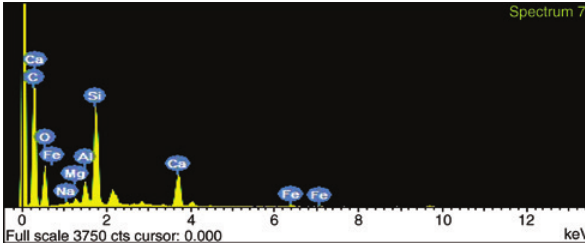
Figure 18: EDAX report of GFRP composites with 3% CNTs.